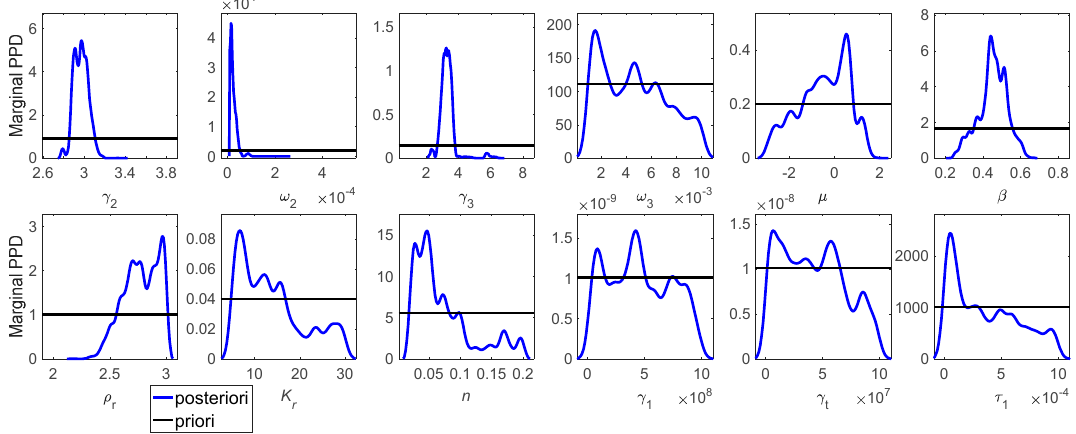
Figure 6. Estimates of one-dimensional marginal PPDs for grain-shearing elastic model parameters.